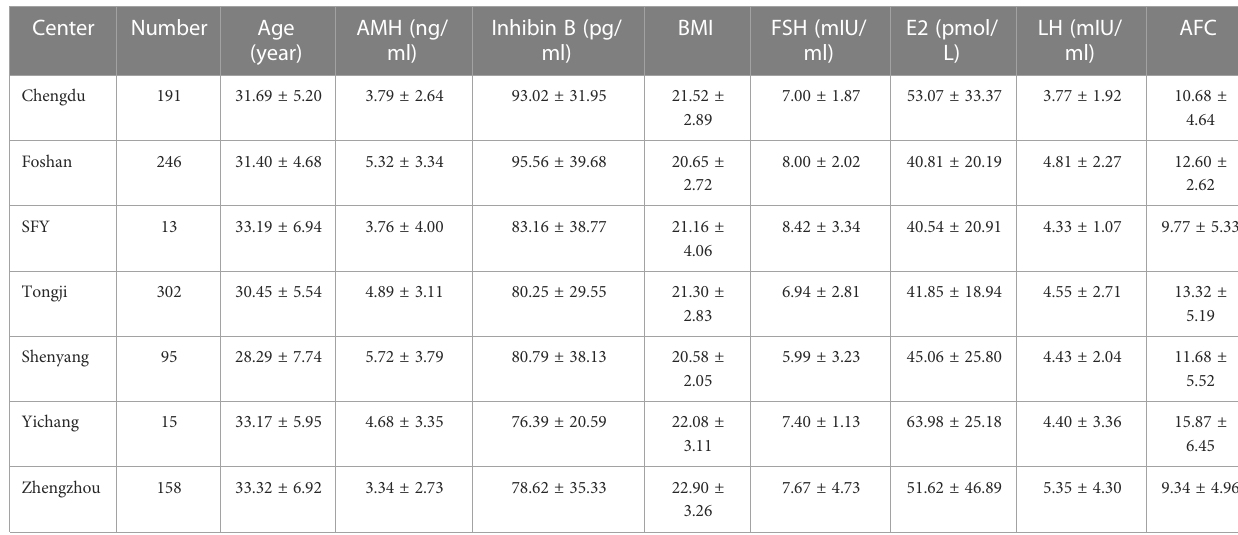
AMH, anti-Müllerian hormone; BMI, body mass index; FSH, follicle-stimulating hormone; E2, estradiol; LH, luteinizing hormone; AFC, antral follicle count.